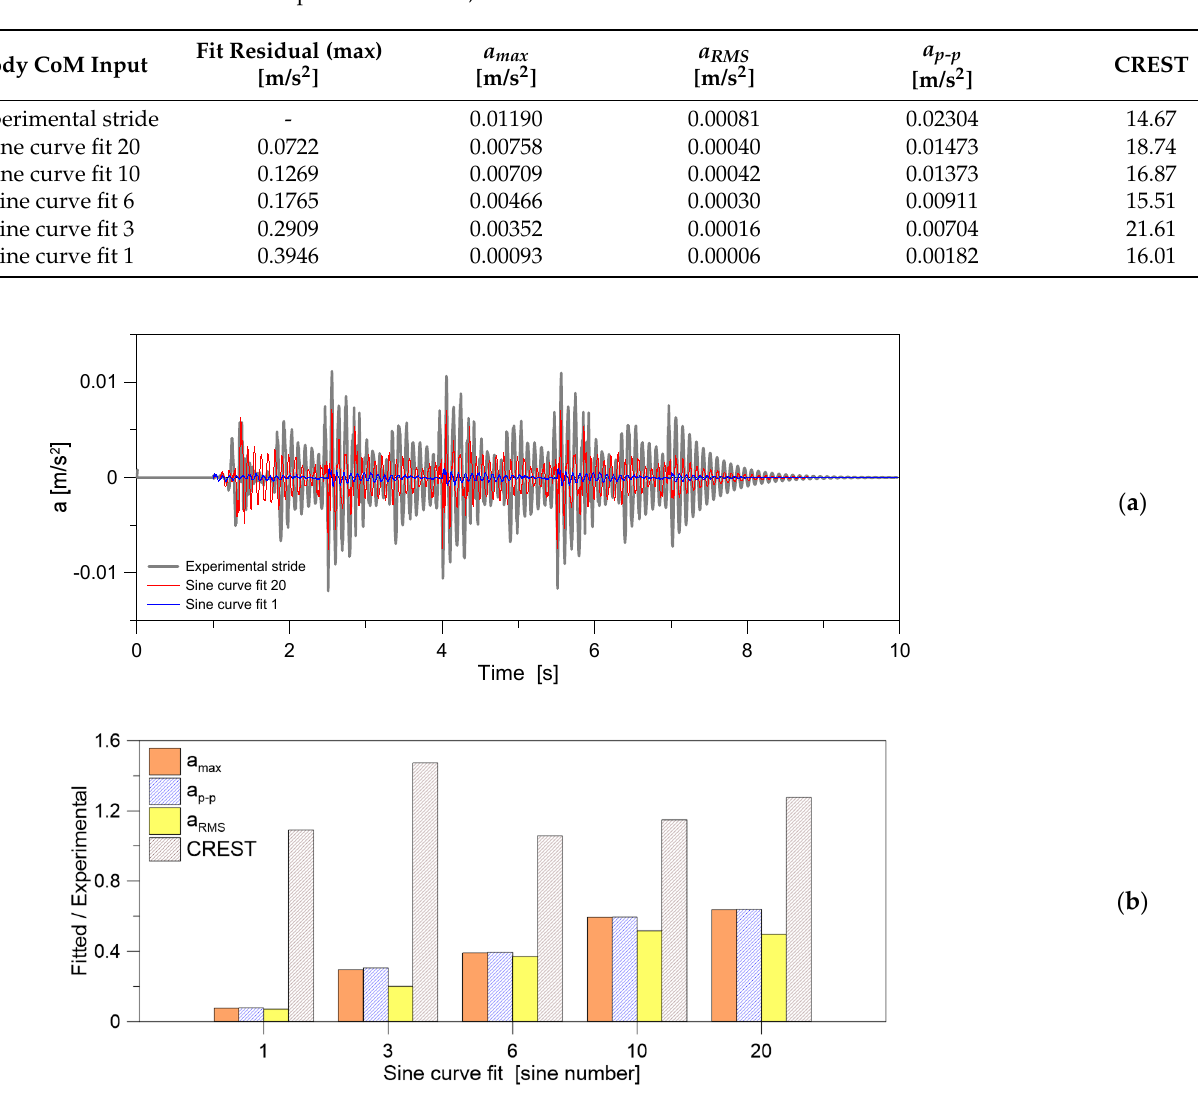
Table 7. Analysis of the examined concrete slab under synthetized body CoM stride acceleration (example for experimental stride from signal #7-W1), with maximum acceleration, RMS value, peak- to-peak acceleration, and CREST factor.